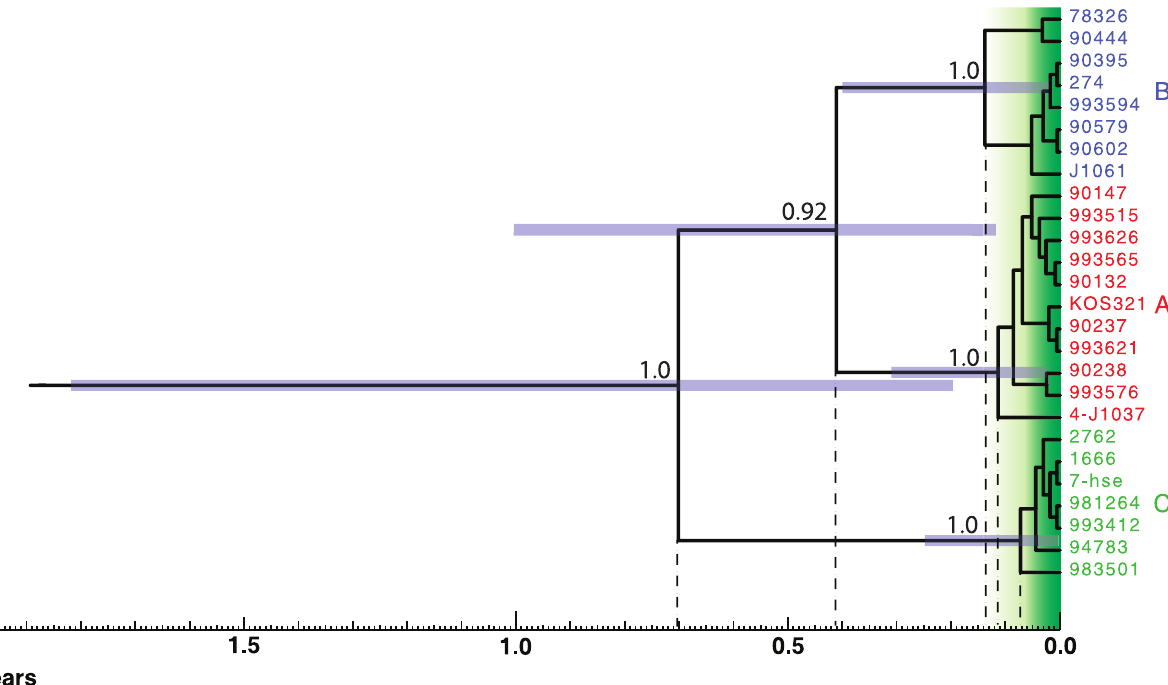
Figure 3. HSV-1 timescale estimation based on the genes US7 and US8. Estimated timescale for the HSV-1 evolution. Each major branch point in the phylogenetic tree is marked with a dotted line to the scale-bar below. The 95% confidence intervals for each predicted time since divergence are denoted with purple bars. The increased number of branch points in each clade is highlighted with green background. Posterior probabilities for the major clades are shown.